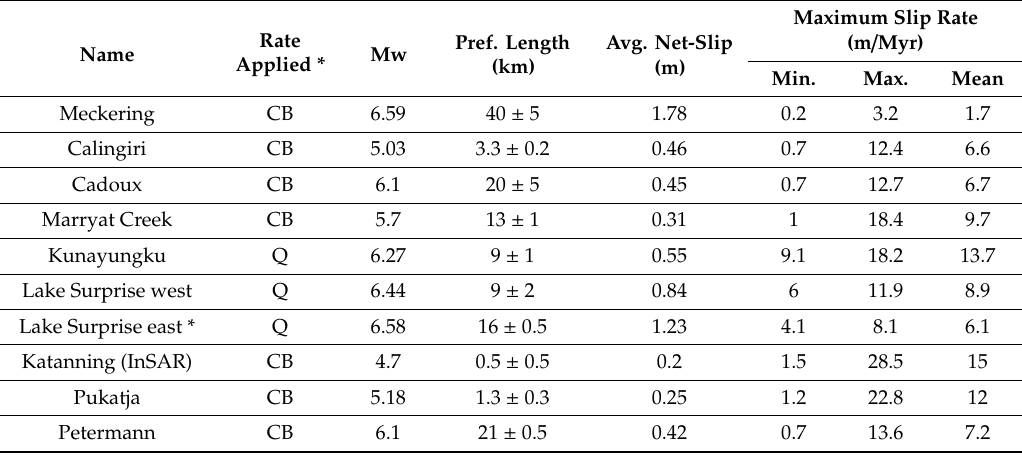
Table 9. Maximum slip rates based on minimum and maximum bedrock erosion rates [109,138] and length-weighted average net-slip values (Table